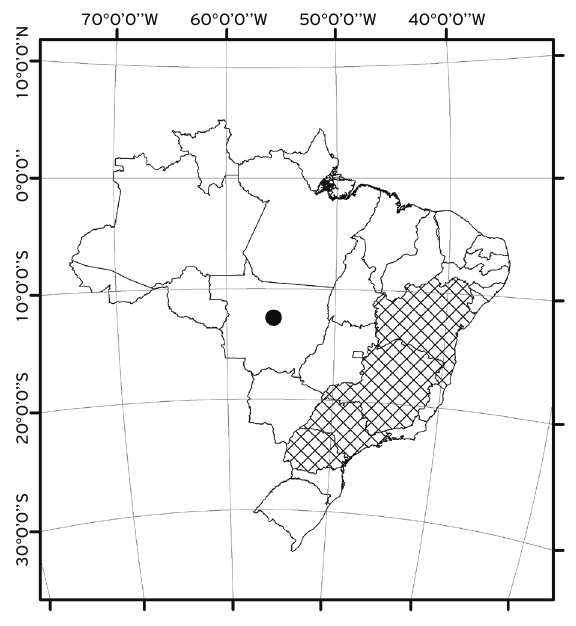
Figura 4. Distribuição de Isogonoceraia divergipennis no